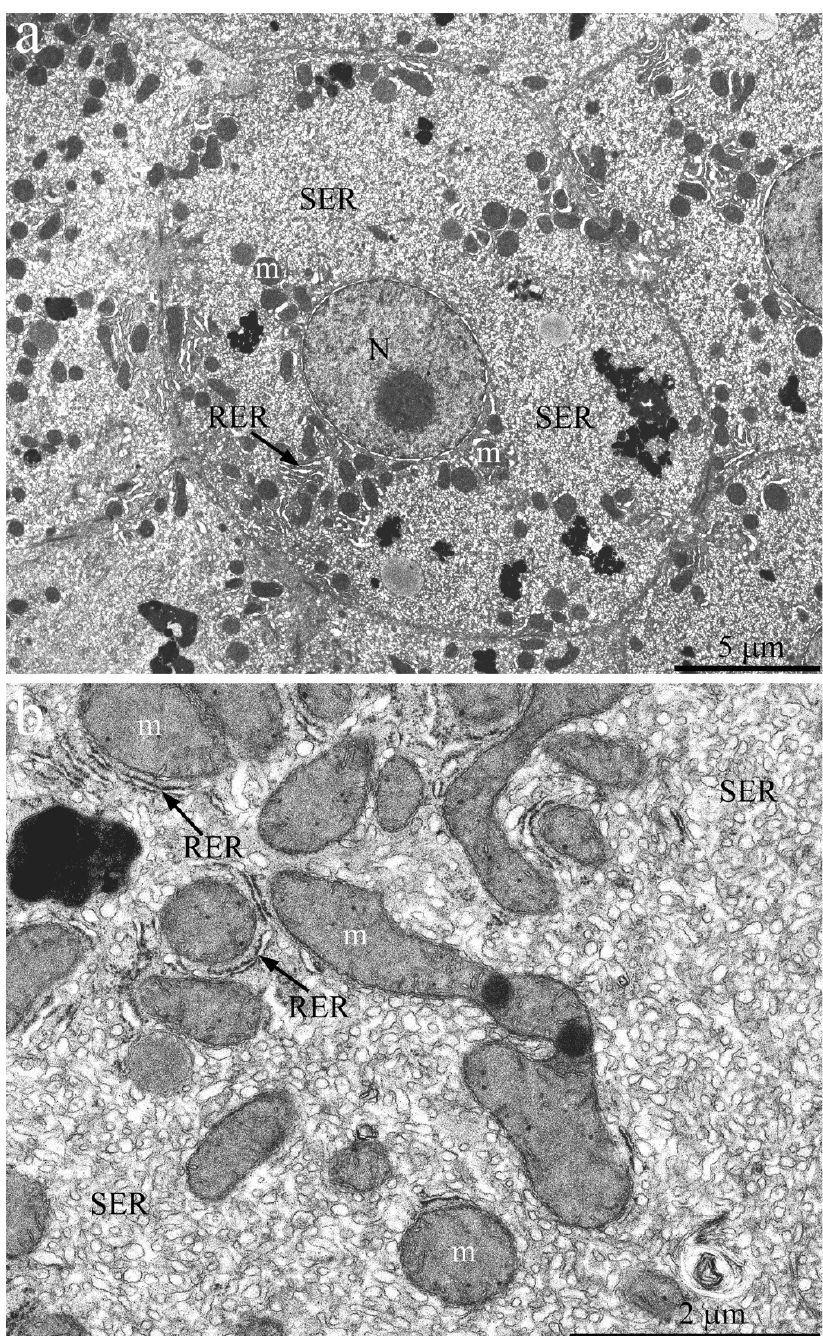
Figure 6. Hepatocyte ultrastructure of H. glaber aged 11 years. ( a ) Overview photograph. The nucleus (N) is located in the center of the cell; most of the cytoplasm is occupied by SER membranes. RER membranes are minor and surround mitochondria (m); ( b ) Features of the internal hepatocyte ultrastructure. Mitochondria (m) in cells are not evenly distributed but are localized in groups mainly in the perinuclear area and in the internal space of the cytoplasm. RER in cells is represented by single cisterns located between mitochondria.